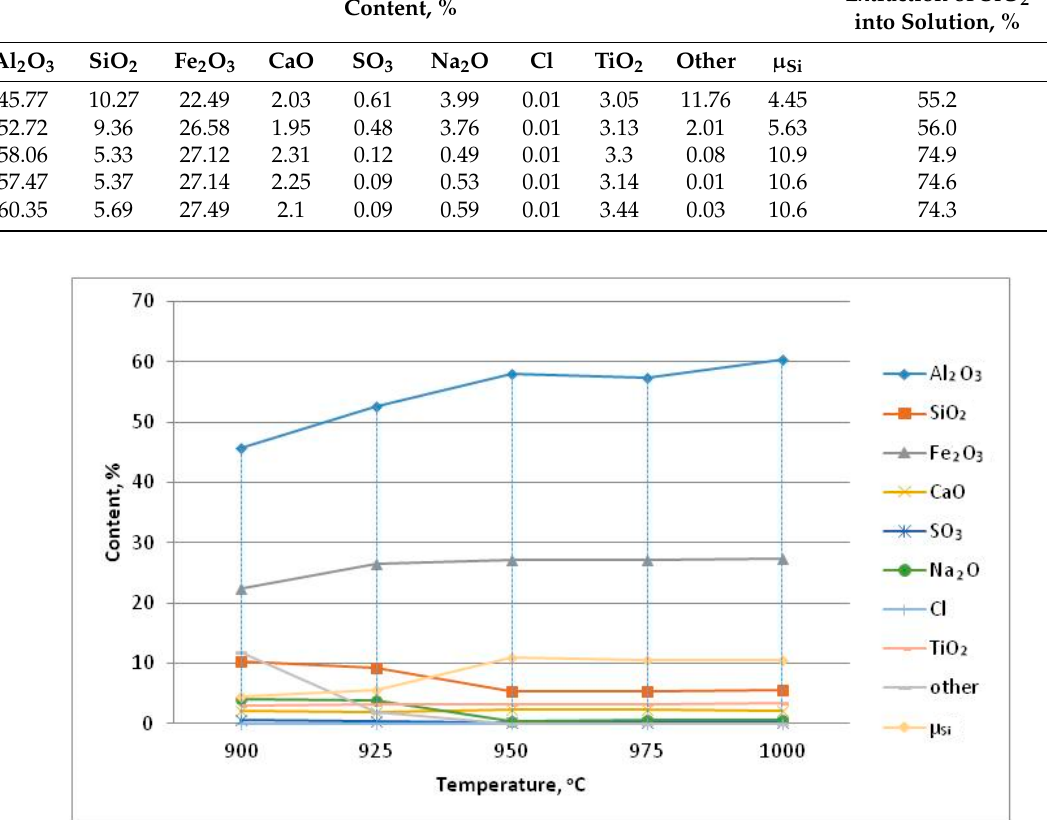
Extraction of SiO 2 into Solution, %